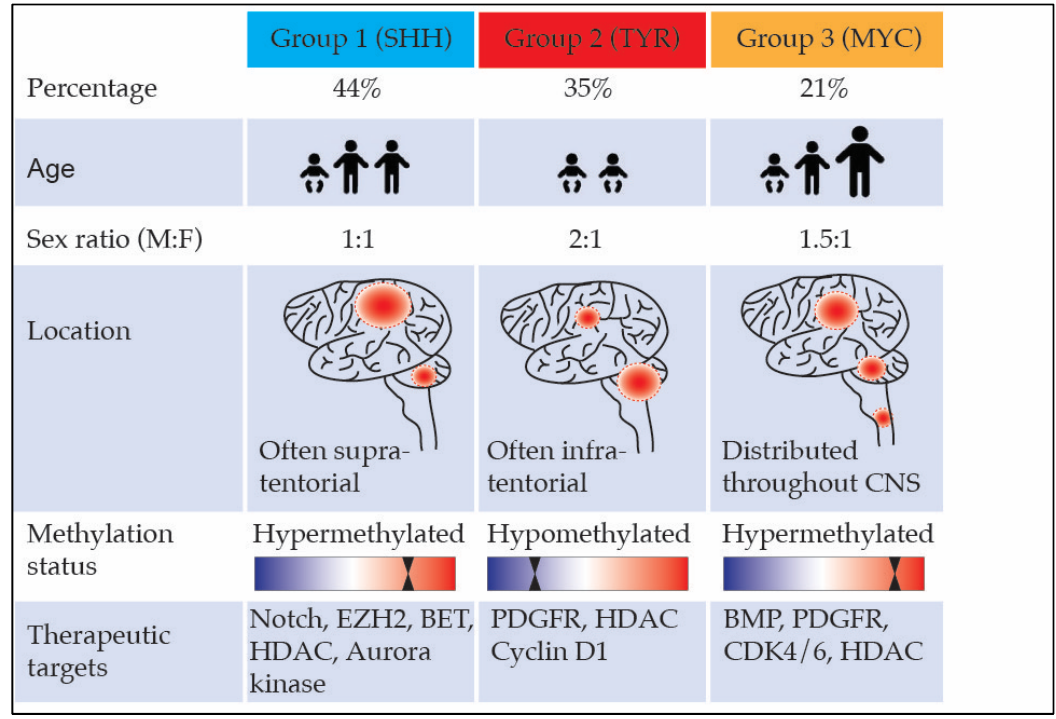
Figure 3. Molecular subgroups of atypical teratoid rhabdoid tumors (ATRT) and their clinical and epigenetic features, as well as therapeutic targets.